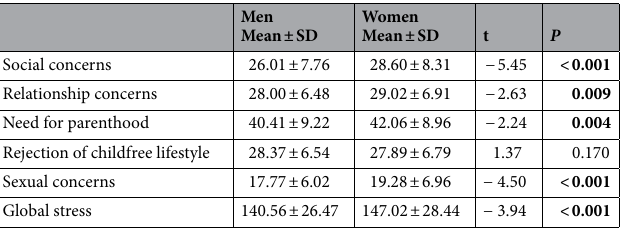
Table 2. The FPI scores of infertile couples (N = 508). Significant values are given in bold.